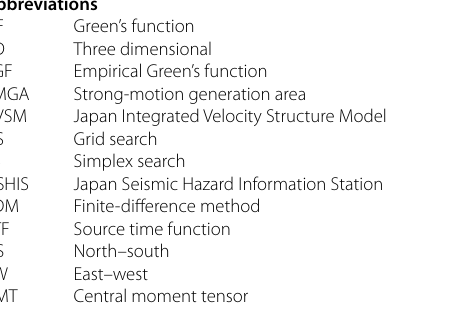
*Here: L 0 {8, 12, 12}, H 0 = is the GS result